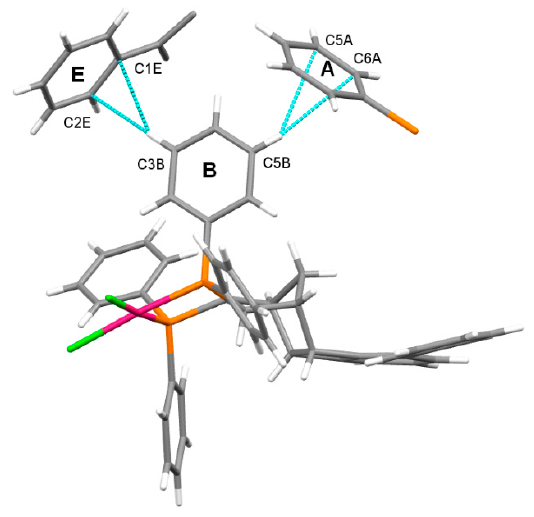
Figure 3. T-shaped π … π interactions in the complex [Pd( 6q )Cl 2 ].